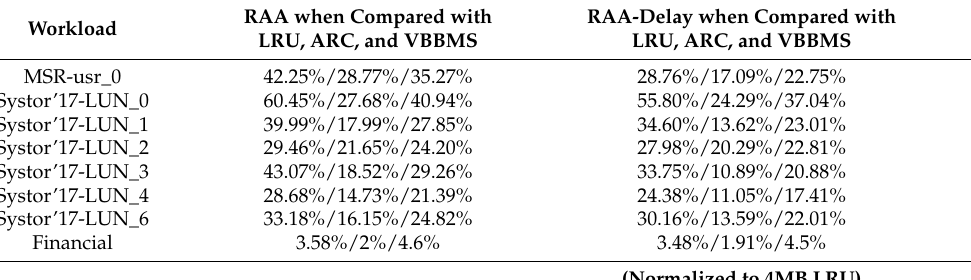
Table 3. Improvement of the average hit